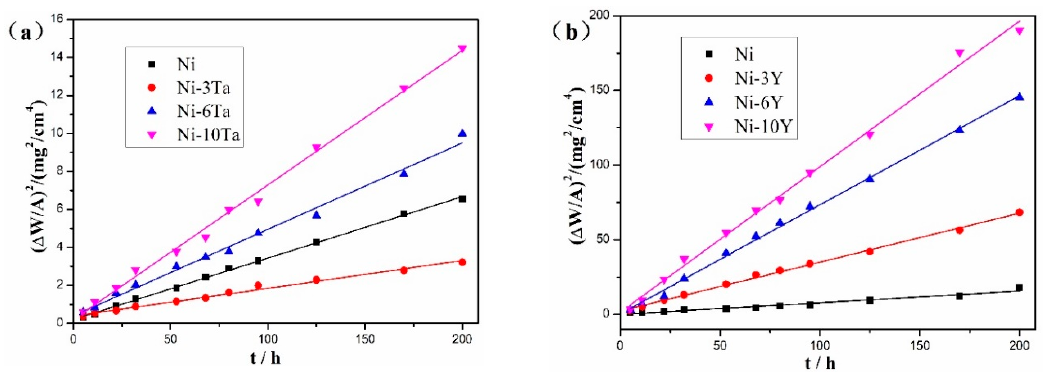
Figure 4. The squares of mass gain of Ni-based alloys as a function of oxidation time at 800 ◦ C: ( a ) Ni-(3~10) Ta alloys and ( b ) Ni-(3~10) Y alloys. Table 2. Values of the parabolic rate constant ( K ), the coefficient of determination ( r ) and mass gain of Ni ‐ based alloys oxidized at 800 °C for 200 h.